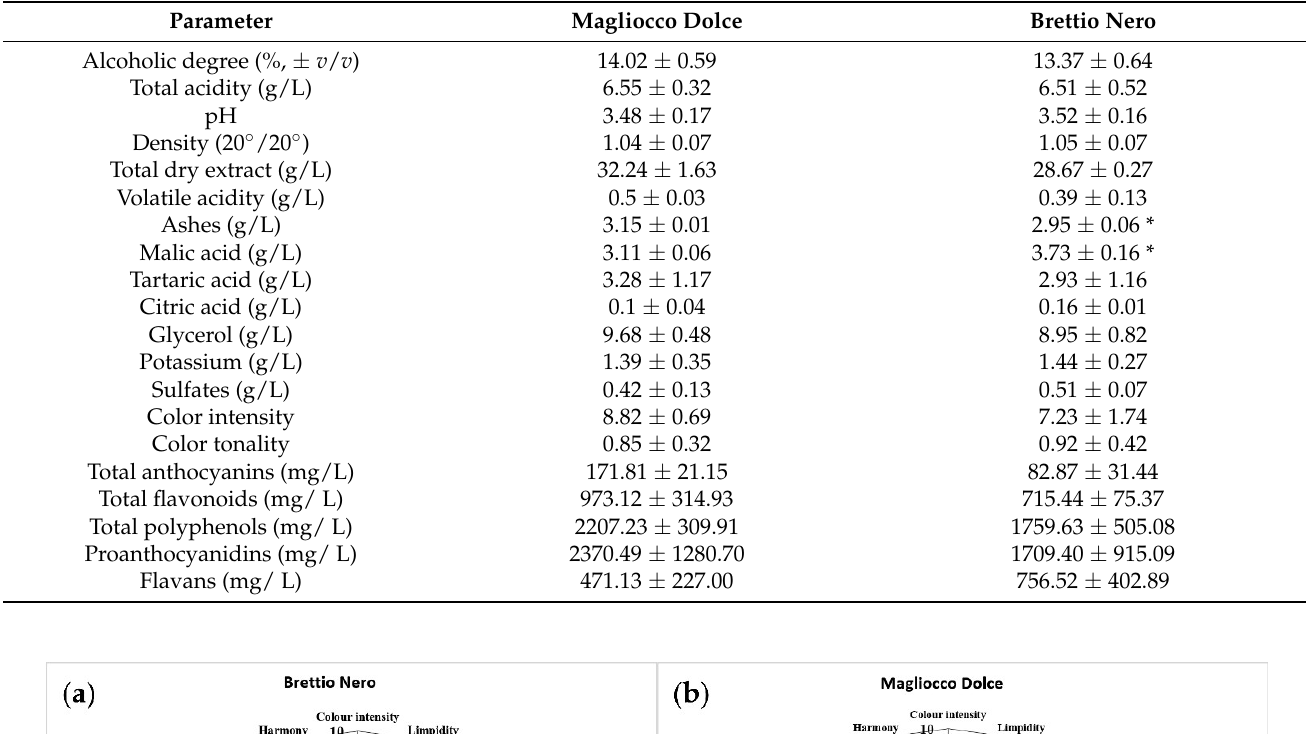
Table 4. Chemical parameters and polyphenols content measured in Magliocco Dolce and Brettio Nero monovarietal wines. Analysis was performed for two seasons (2016–2017). Standard unpaired Student’s t -test was used for comparison of two varieties, * p < 0.05.